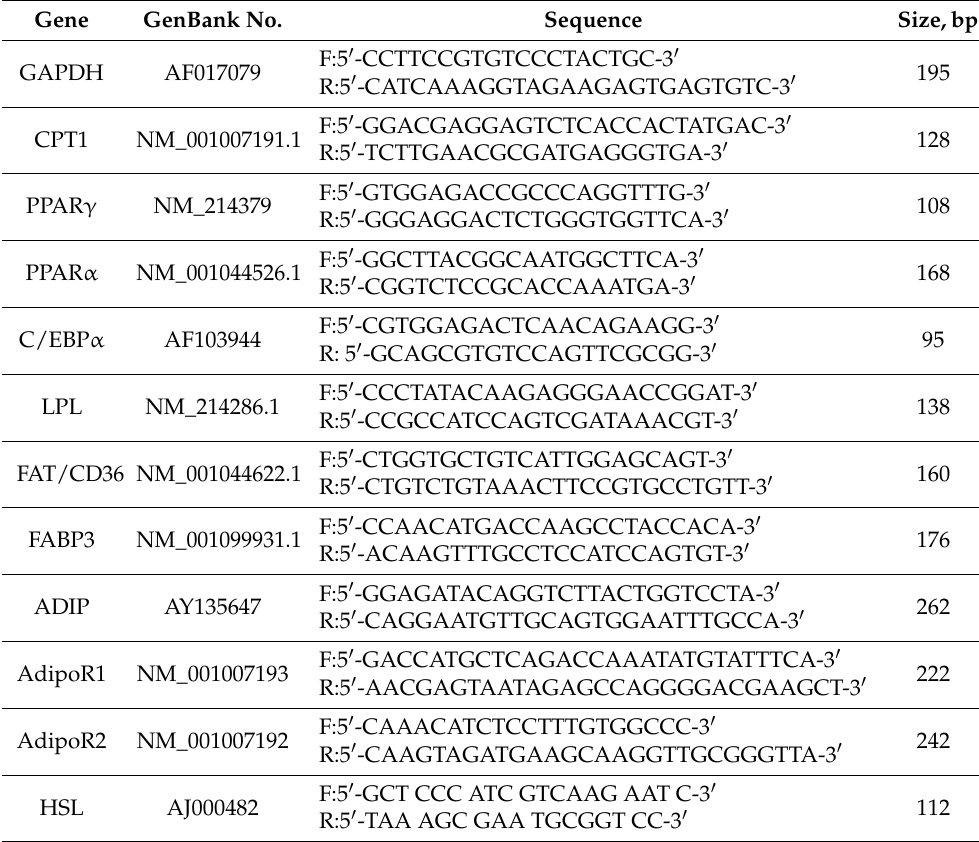
Table 3. Oligonucleotides used on gene expression